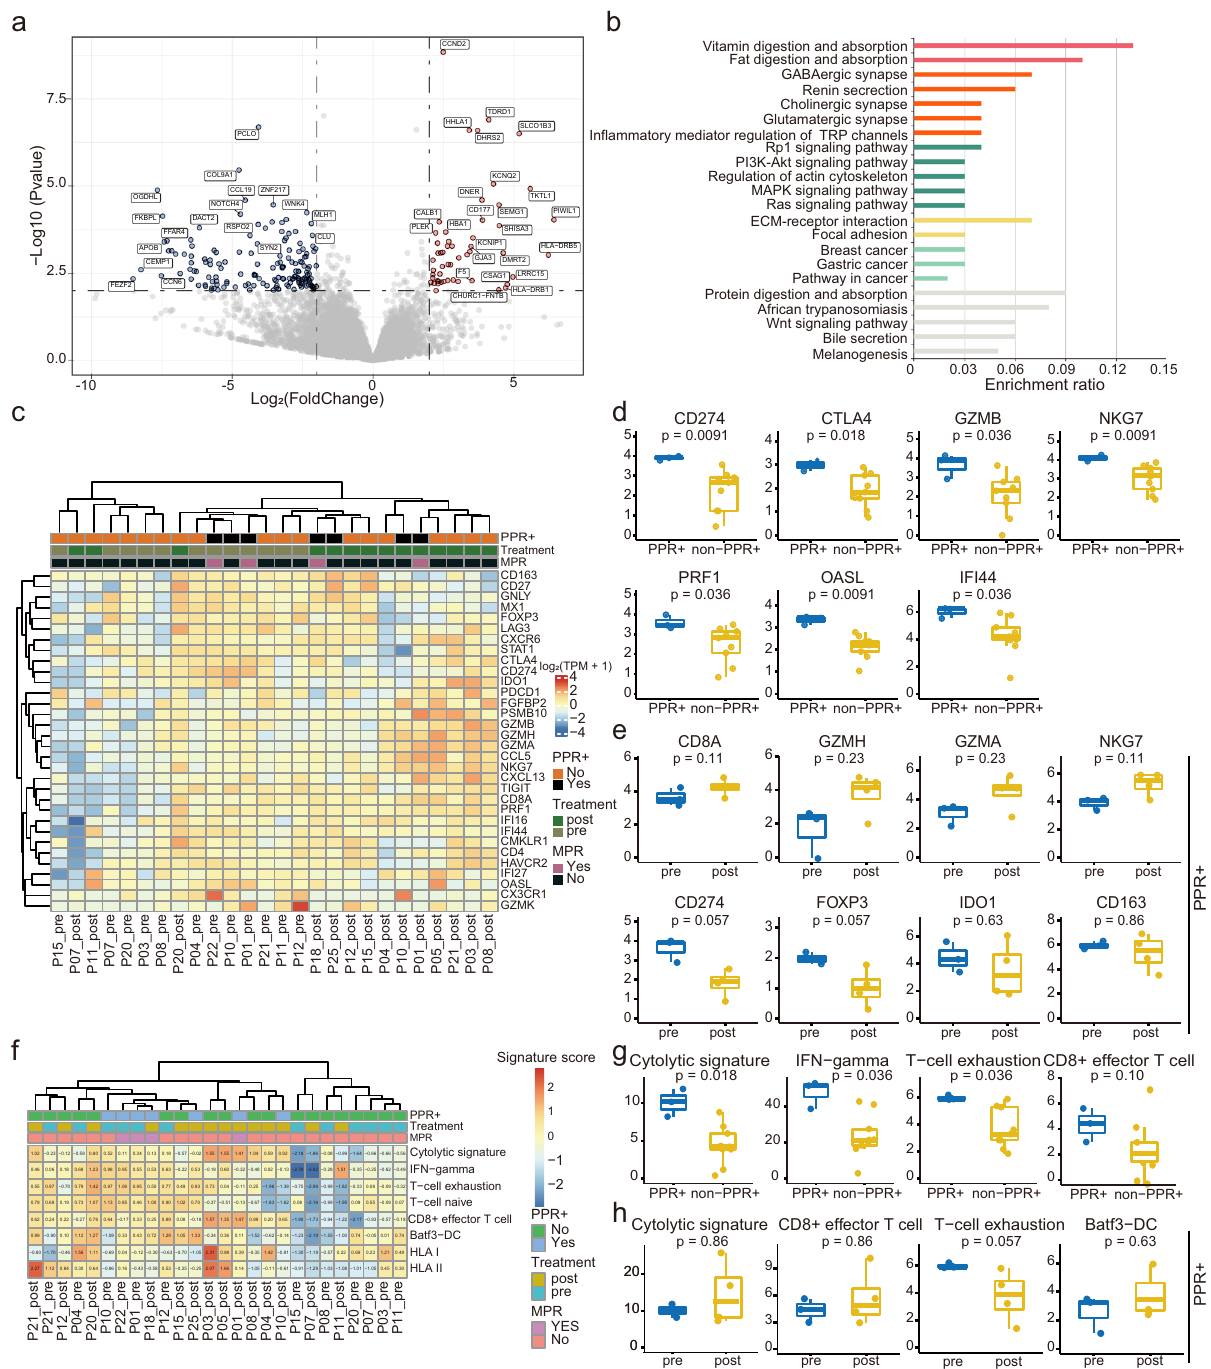
Fig. 4 | Transcriptomic features in patients withdifferent responses. a Volcano plot showing differentially expressed genes between baseline MPR ( n =2) vs. non- MPR ( n =10) group. Color dots denote genes that passed the p-value and fold change thresholds. b Functional pathway enrichment by differential expressed genes at baseline. Similarpathways areclustered and stained with the same colors. c Heatmap for immune-related gene expression across samples in 15 patients. d Baseline levels of immune-related genes that were altered between PPR+ ( n =3) and non-PPR+ (n=9) groups. e Level changes of immune-related genes between